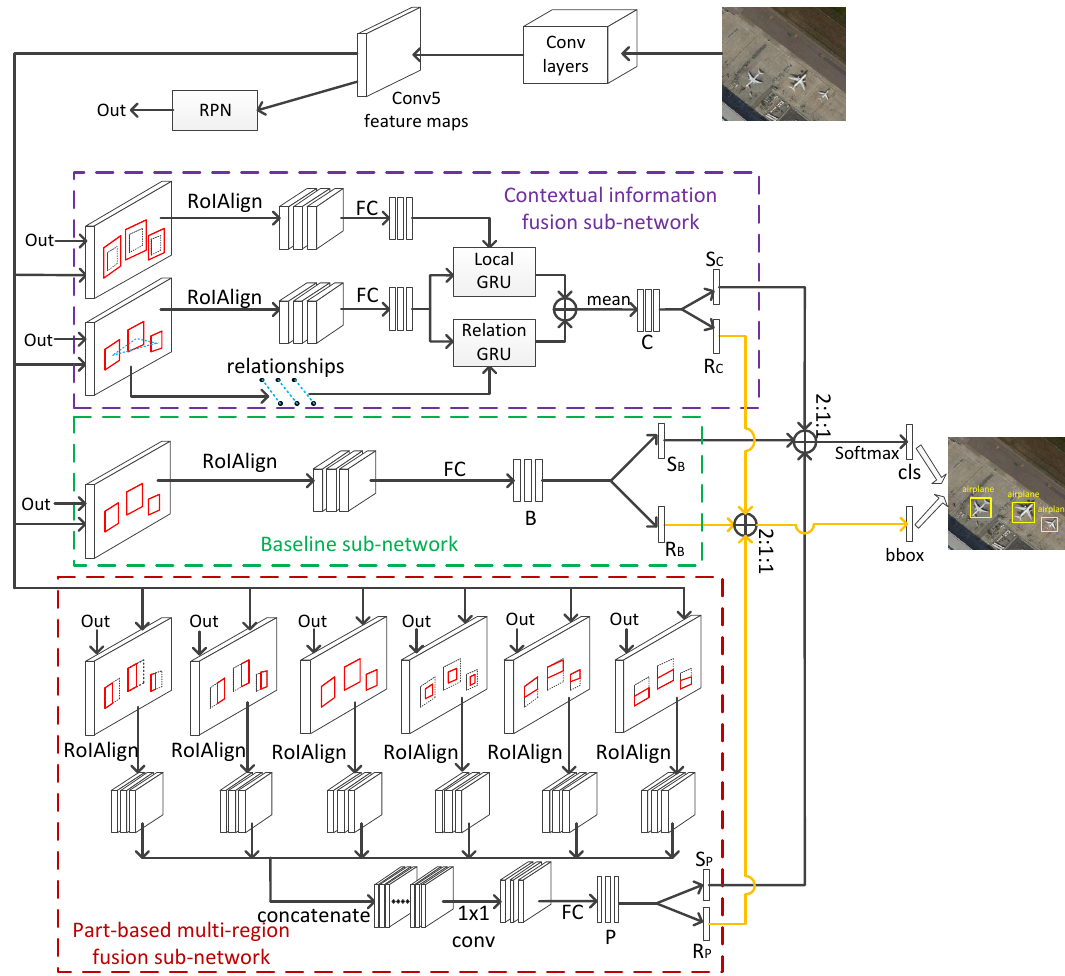
Figure 3. The proposed framework, which is made up of four parts. (1) A contextual information fusion sub-network; (2) a part-based multi-region fusion sub-network; (3) a baseline sub-network; (4) the last multi-model decision fusion